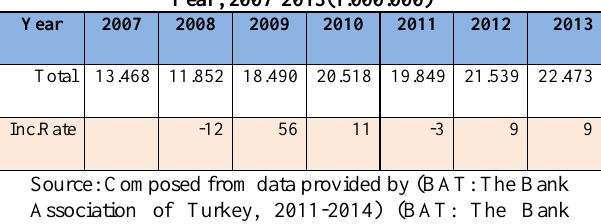
Table-13: Net Profit/Loss of Deposit Banks for the